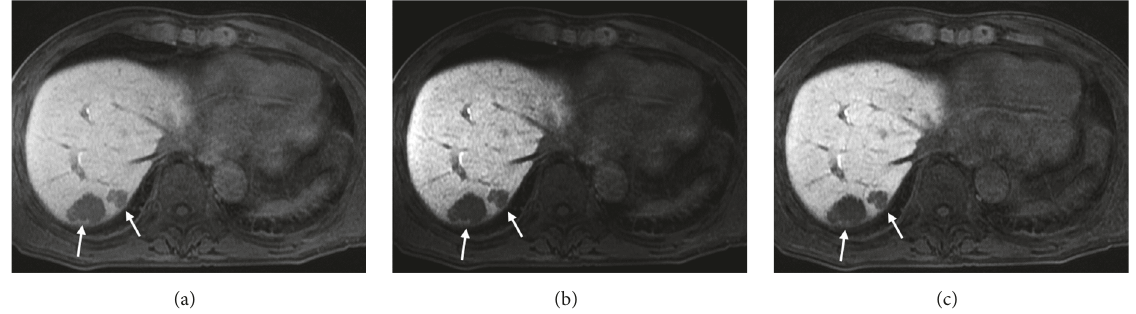
Figure 1: A low-FA original image (a), a low-FA gamma-1.8 image (b), and a high-FA image (c) in a 66-year-old man with metastatic liver tumor (arrows).